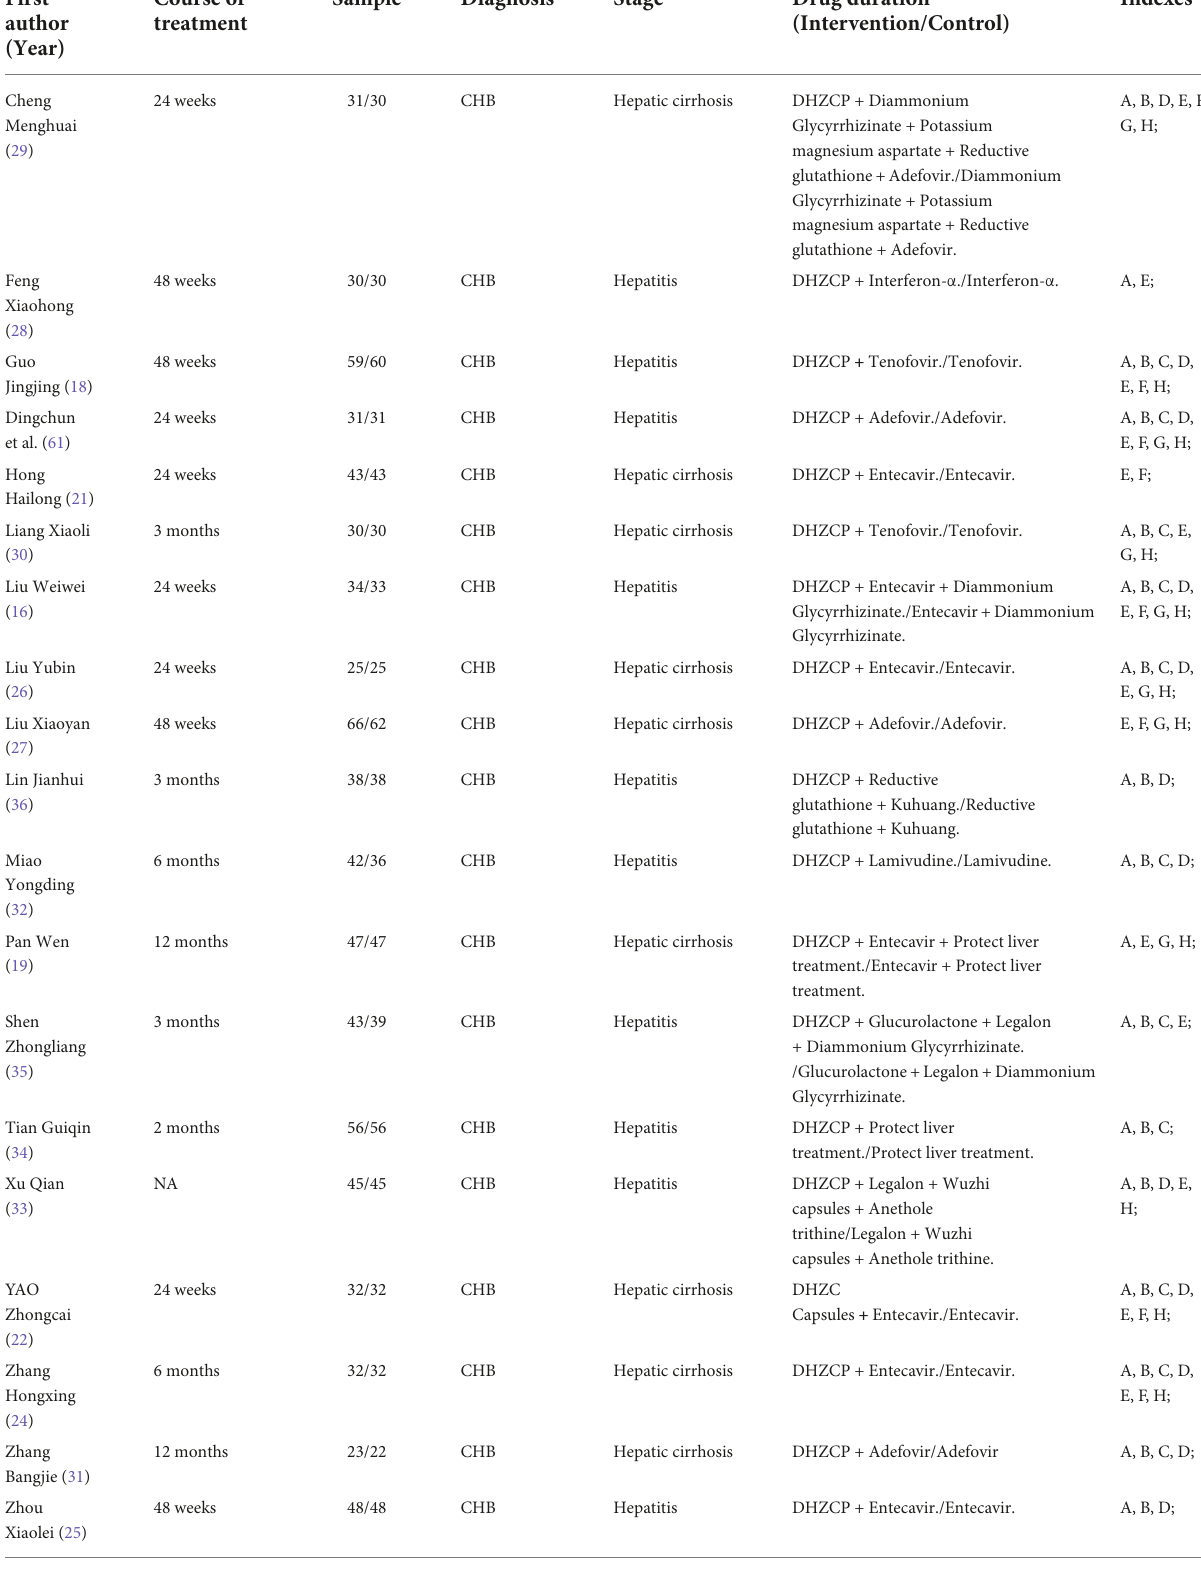
TABLE 1 The characteristics of included clinical